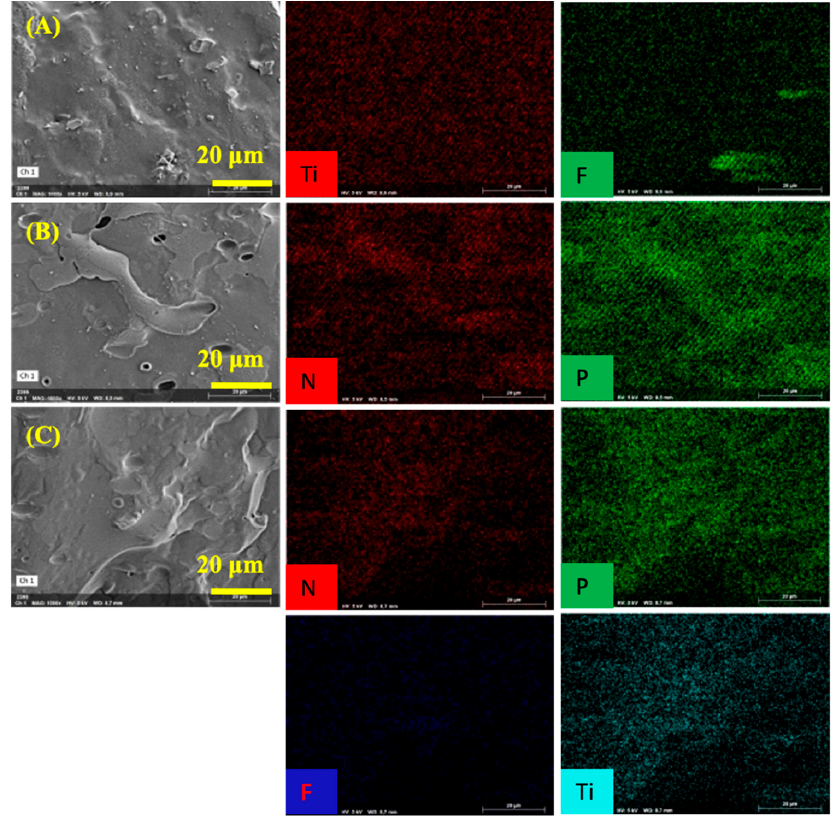
Figure 3. SEM and element-mapping images of PVA and MXene/PVA nanocomposites after brittle fracture: ( A ) MXene 1 . 0% /PVA; ( B ) PVA-PVPA 10% -PEPA 5% ; and ( C ) MXene 1 . 0% /PVA-PVPA 10% -PEPA 5% .